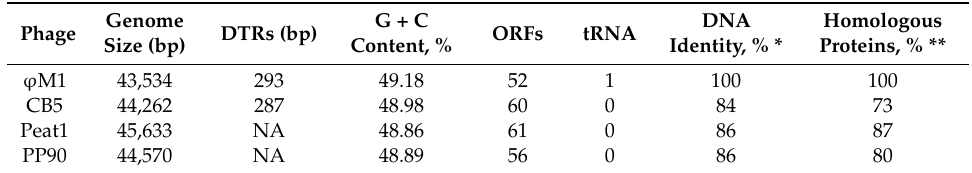
Table 2. Properties of the seven phages belonging to the proposed genus of ‘ Phimunavirus ’. ORF: open reading frame; DTR: direct terminal repeat.